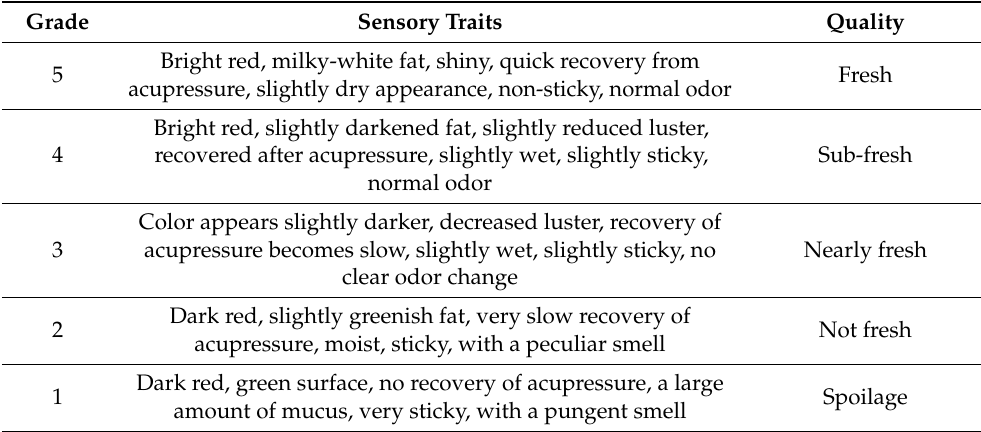
Fresh Sub-fresh Nearly fresh Not fresh